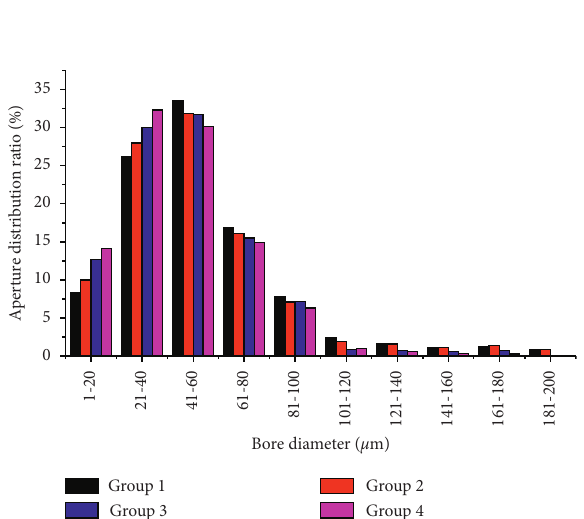
Figure 15: Total aperture distribution ratio of each group of specimens.